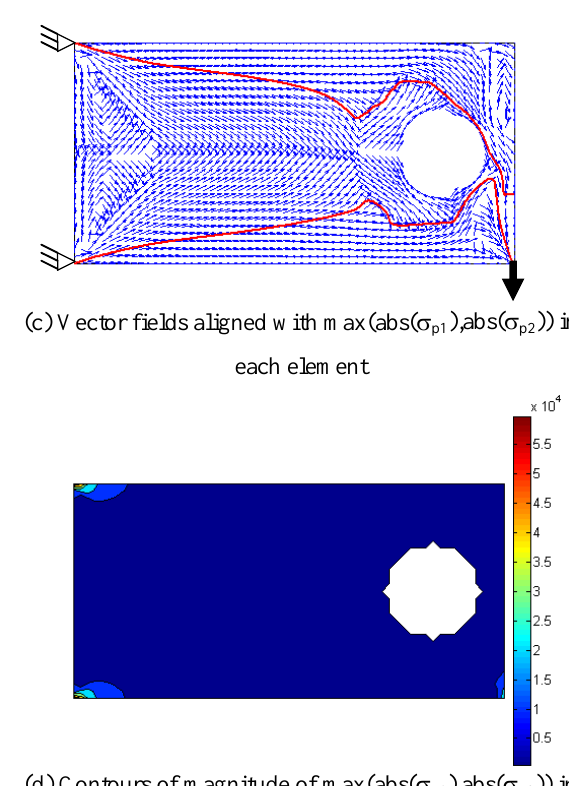
Fig. 21. Load paths based on principal stresses with a hole in the